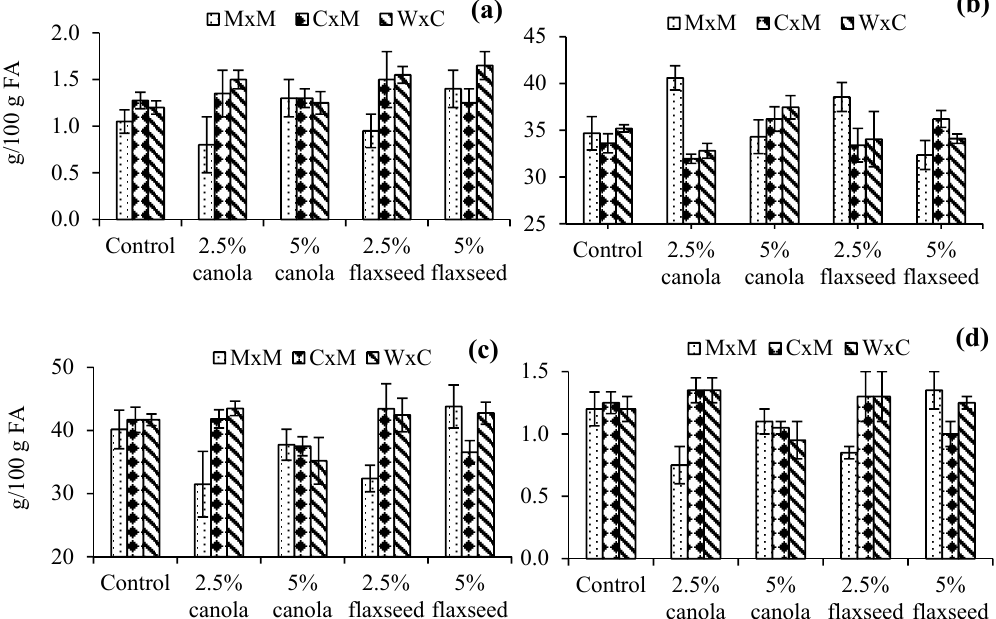
Figure 1. Interaction effects on: ( a ) docosapentaenoic acid, ( b ) total SFA, ( c ) total PUFA compositions and ( d ) PUFA/SFA ratio of lamb hearts (M × M: Merino × Merino; C × M: Corriedale × Merino; W × C: White Suffolk × Corriedale).